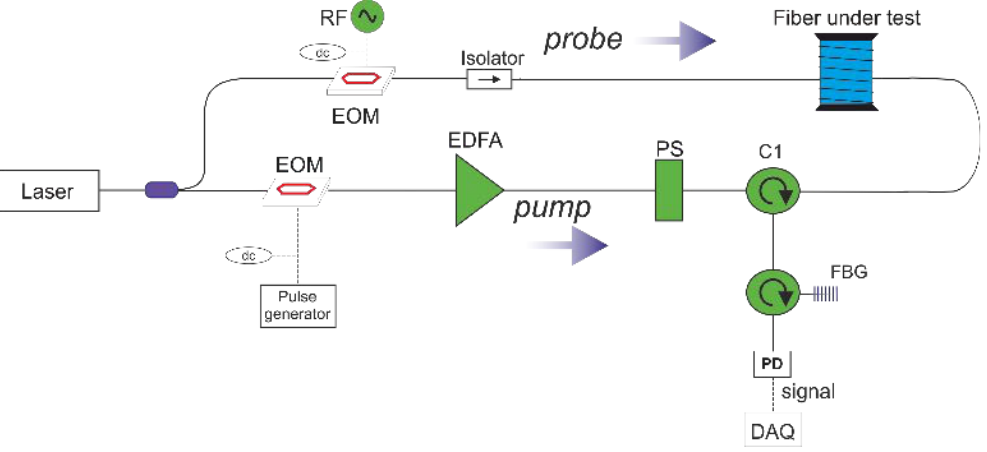
Figure 1. Experimental setup for distributed measurement of temperature in optical fibers. (EOM) electro-optic modulator; (PS) polarization scrambler; (EDFA) erbium-doped fiber amplifier; (PD) photodetector; (FBG) fiber Bragg